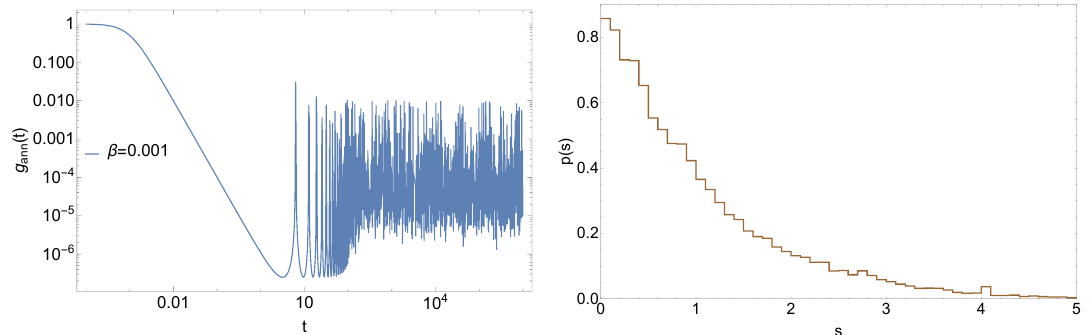
Figure 20. Annealed SFF and its level spacing for SHO with n cut = 300 , β = 0 . 001 . Averaging is done over hundred randomly chosen ω from a normal distribution with mean µ = 1 and variance σ = 0 . 01